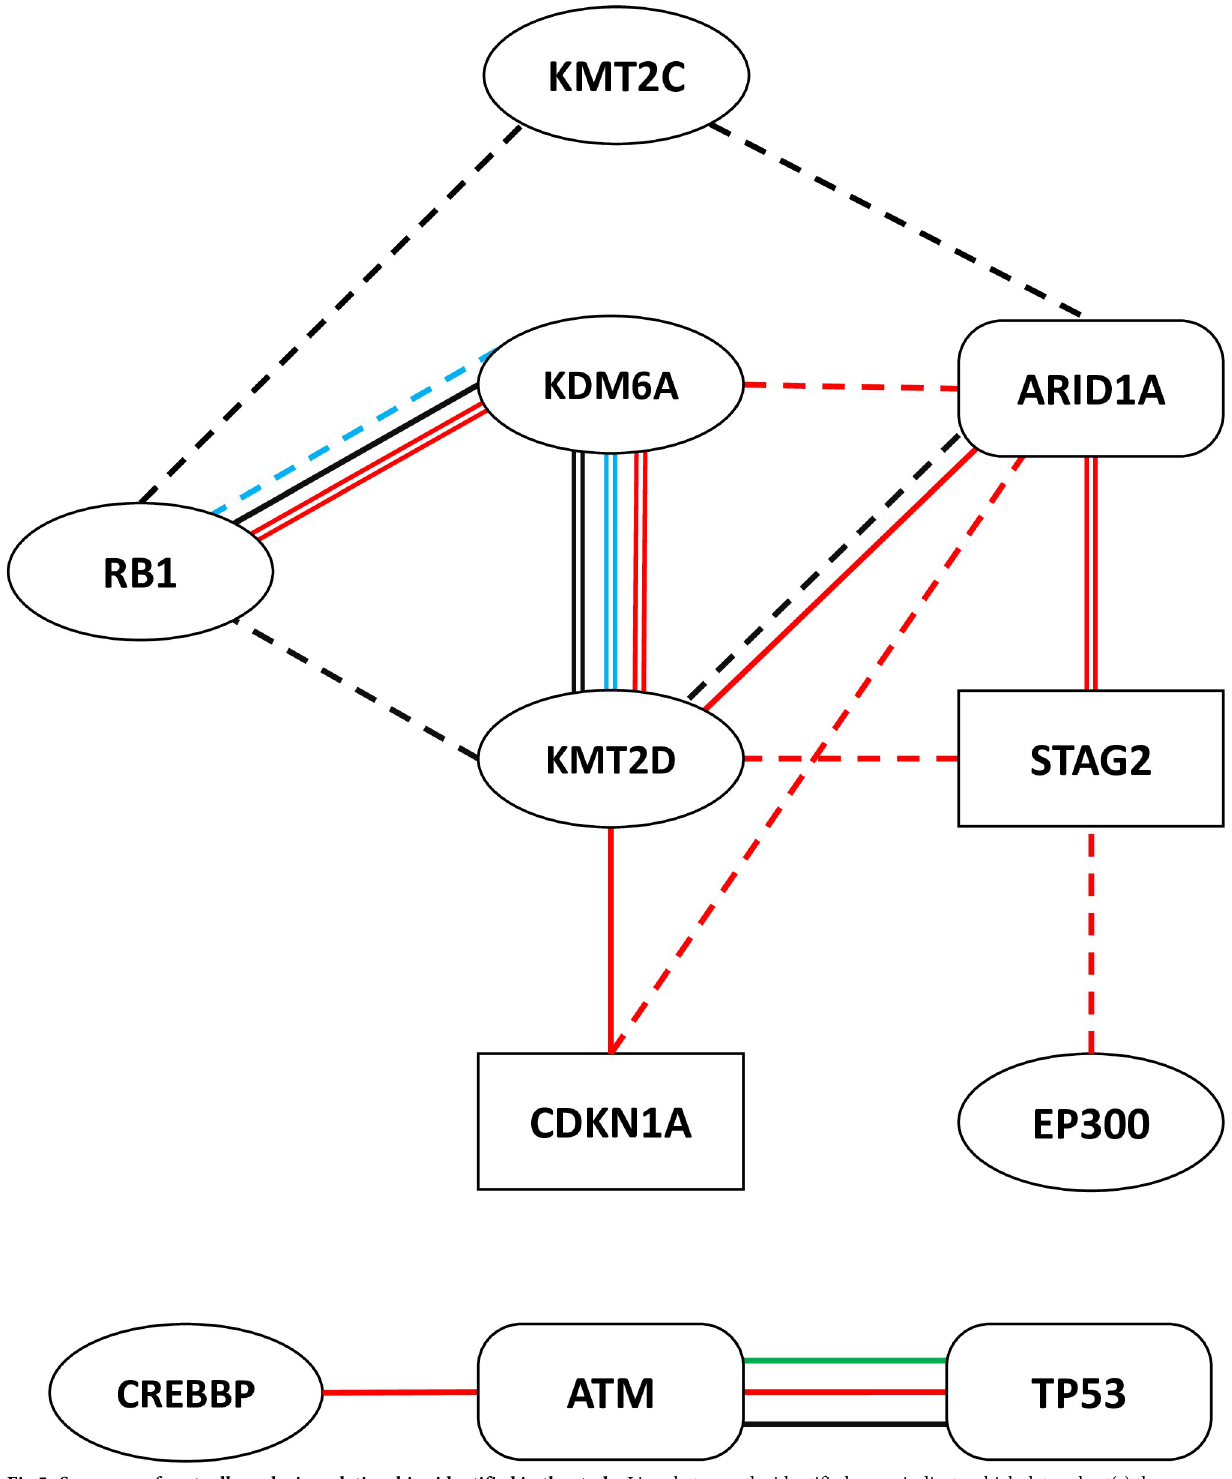
Fig 5. Summary of mutually exclusive relationships identified in the study. Lines between the identified genes indicate which data subset(s) the relationships were identified in, as well as the statistical strength of the observations. DDR genes are indicated by square frames, CM genes by oval frames, and genes overlapping both processes in rectangular frames with round corners. Interactions are shown for: Least High and Moderate Impact Mutations (red lines), Least High Mutations only (blue lines), Mid High and Moderate Impact Mutations (black lines), and Most High and Moderate Mutations